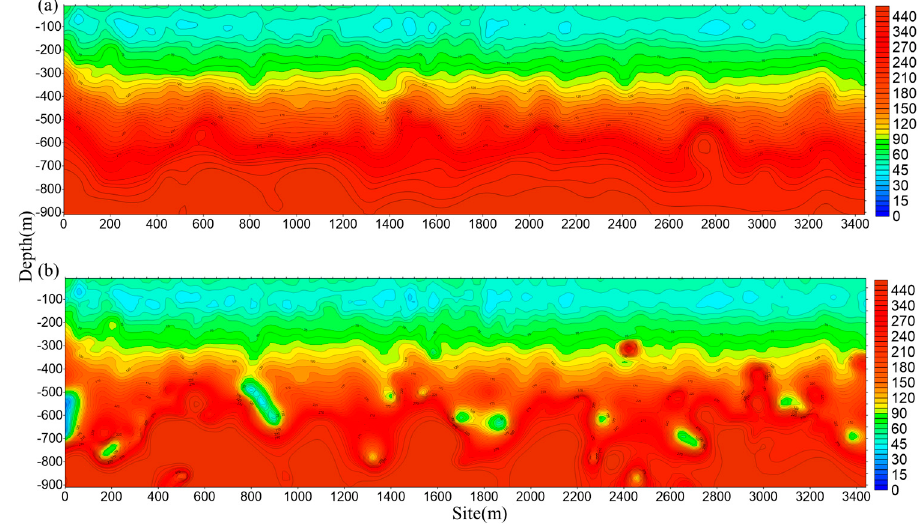
Figure 12. Comparison of detection performance utilizing different systems: ( a ) air coil and ( b ) air coil and core coil.